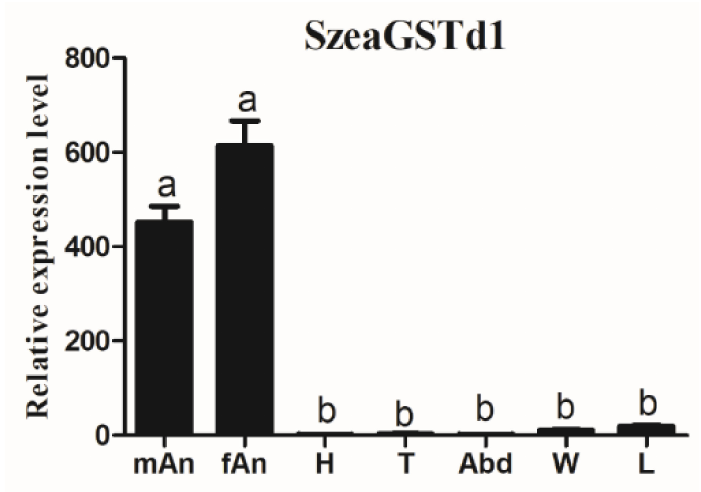
Figure 3. The relative expression levels of SzeaGSTd1 in different tissues. mAn: male antenna; fAn: female antenna; H: head; T: thorax; Abd: abdomen; W: wing; L: leg. The error bars represent the standard errors calculated from three replicates. Different letters on the error bars indicate significant differences analyzed by the ANOVA and HSD test ( p <